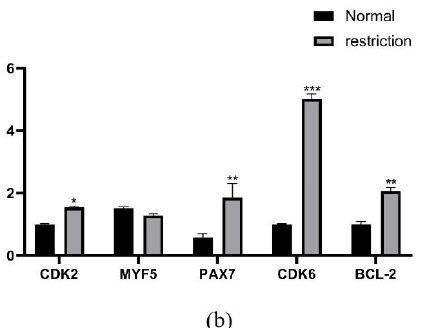
Figure 8. Low nutrient culture affects the sheep primary embryonic myoblast proliferation and growth. ( a ) The different period phenotypes of sheep primary embryonic myoblasts cultured with DMEM/F12 (low nutrition) and DMEM/F12 containing 10% FBS (normal nutrition). ( b ) qRT-PCR results of the related genes with the two experimental groups, p < 0.05 (*), p < 0.01 (**), or p < 0.001 (***).